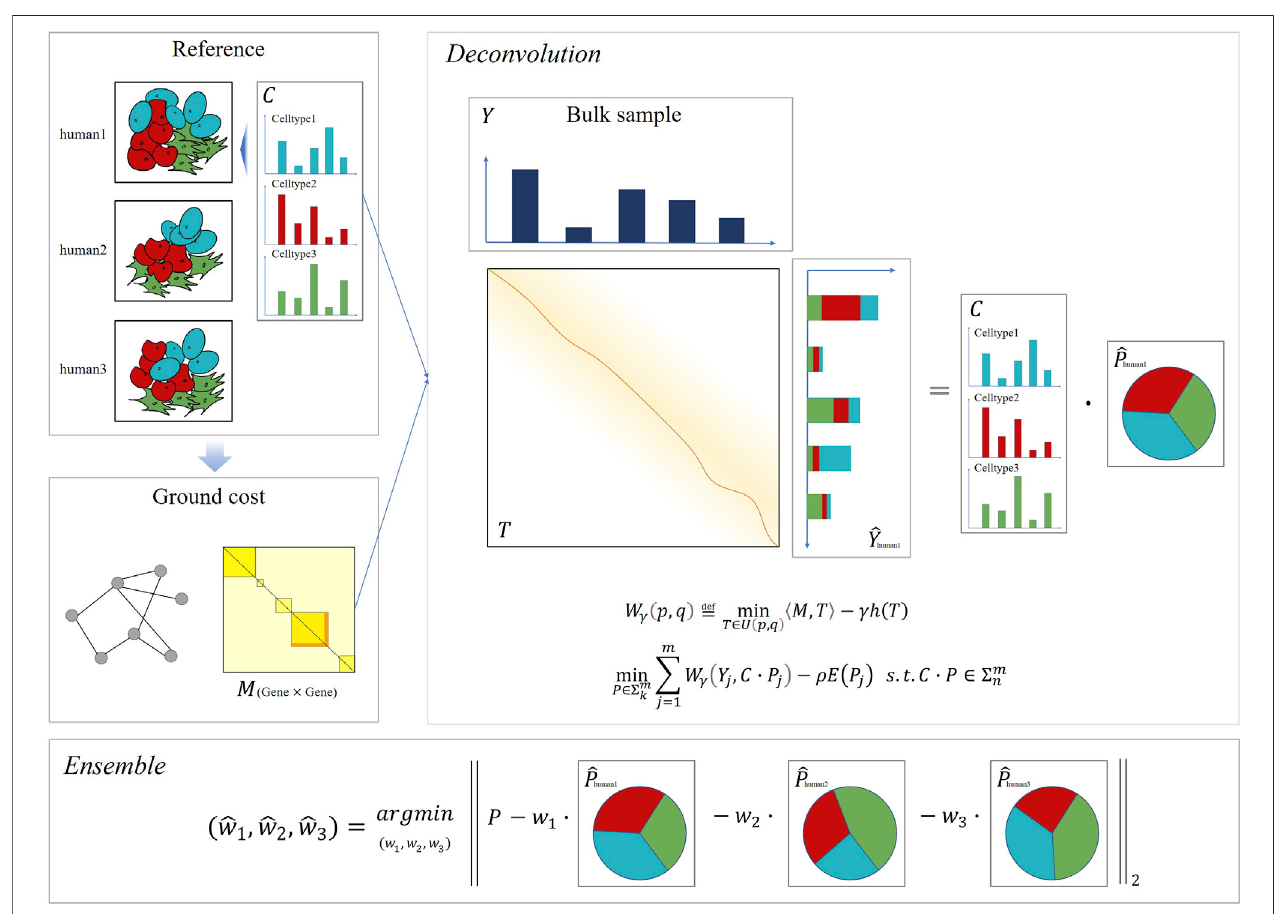
FIGURE 1 | Overview of DecOT. Based on the Wasserstein loss, DecOT fi rst converts the gene expression of single-cell and bulk samples into distributions. Next, DecOT calculates the ground cost matrix from the single-cell expression data, which forms the correlations among genes, see Ground Cost Selection for details. Then, for each individual reference, DecOT fi nds the optimal proportion of cell types by minimizing the Wasserstein loss under the premise of a given ground cost. Finally, in order to resolve the impact of batch effects between individuals, DecOT uses an ensemble framework to weigh each individual ’ s deconvolution result.